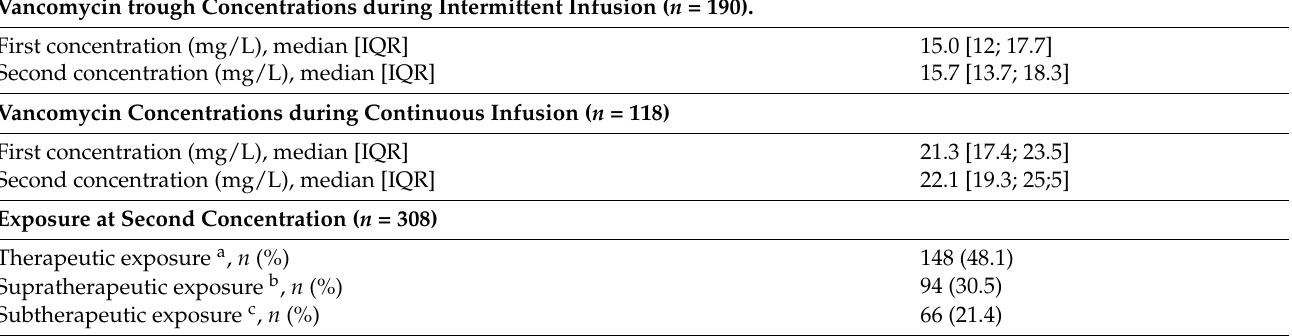
Table 2. Vancomycin concentrations (two pairs per patient) during intermittent (trough) and continu- ous